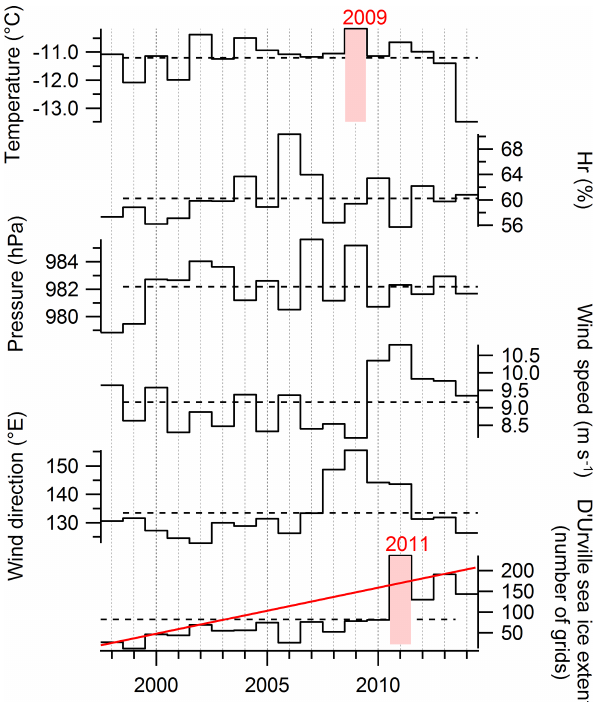
Figure 6. Meteorological time series over the period 1998–2014 av- eraged at the inter-annual scale. Near-surface temperature ( ◦ C), rel- ative humidity (%), sea level pressure (hPa), wind speed (ms − 1 ) , and direction ( ◦ E) were provided by Météo France. The local sea ice concentration (%) is extracted in the 135–145 ◦ E sector (with a latitudinal range of 50–90 ◦ S) from the Nimbus-7 Scanning Multi- channel Microwave Radiometer (SMMR) and Defense Meteorolog- ical Satellite Program Special Sensor Microwave/Imagers – Special Sensor Microwave Image/Sounder (DMSP SSM/I-SSMIS) passive microwave data (Cavalieri et al., 1996). Horizontal dashed lines cor- respond to the climatological averages over 1998–2014 for each pa- rameter. Remarkable years, i.e. associated with values deviating by at least 2 standard deviations from the climatological mean value, are highlighted with red shading (positive anomalies) or blue shad- ing (negative anomalies). The same figure with standard deviations is available in the Supplement (Fig. S2).